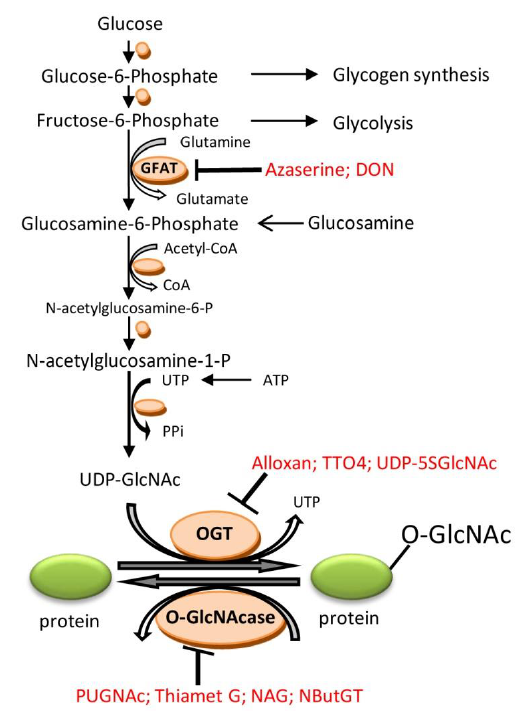
Figure 1. The hexosamine biosynthsis pathway (HBP) and protein O-GlcNAcylation. Enzymes are illustrated by orange circles. Blockers are written in